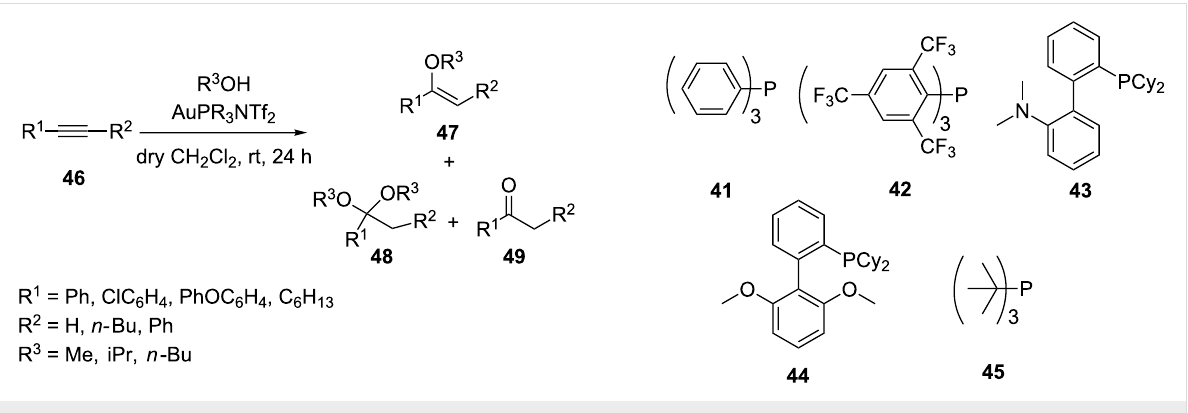
Scheme 8: Gold-catalyzed intermolecular hydroalkoxylation of alkynes. PR 3 = 41–45 .